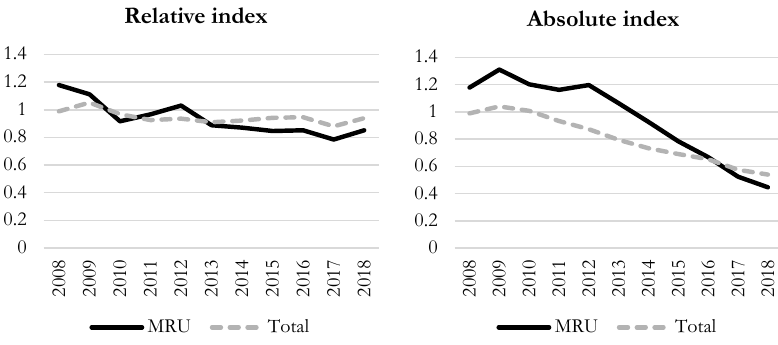
Fig. 3 – Relative and absolute indexes of students’ number dynamics. Source: own